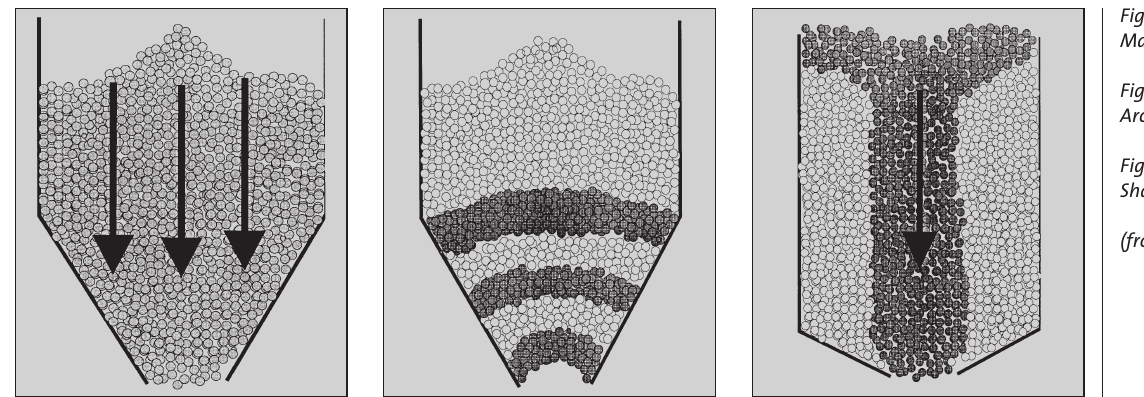
(from left to right)